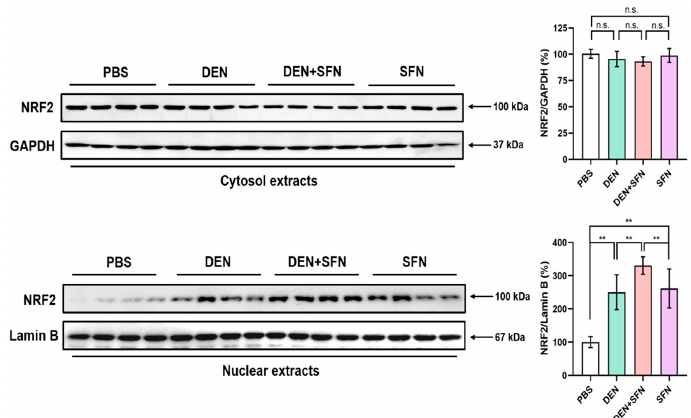
Figure 5. Effect of SFN administration on the nuclear translocation of NRF2 in the livers of DEN- treated mice. Cytosol and nuclear extracts prepared from the livers of 9-month-old mice treated with vehicle (PBS), DEN, DEN plus SFN, or SFN alone ( n = 4 for each group) were subjected to Western blotting with antibodies against NRF2. GAPDH and Lamin B served as internal controls for cytosol and nuclear extracts, respectively. The quantification of protein levels of NRF2 was conducted, and the statistical significance was determined by the two-tailed unpaired Student’s t test. Data are shown as the mean ± SD. ** p < 0.01; n.s.: non-significant.